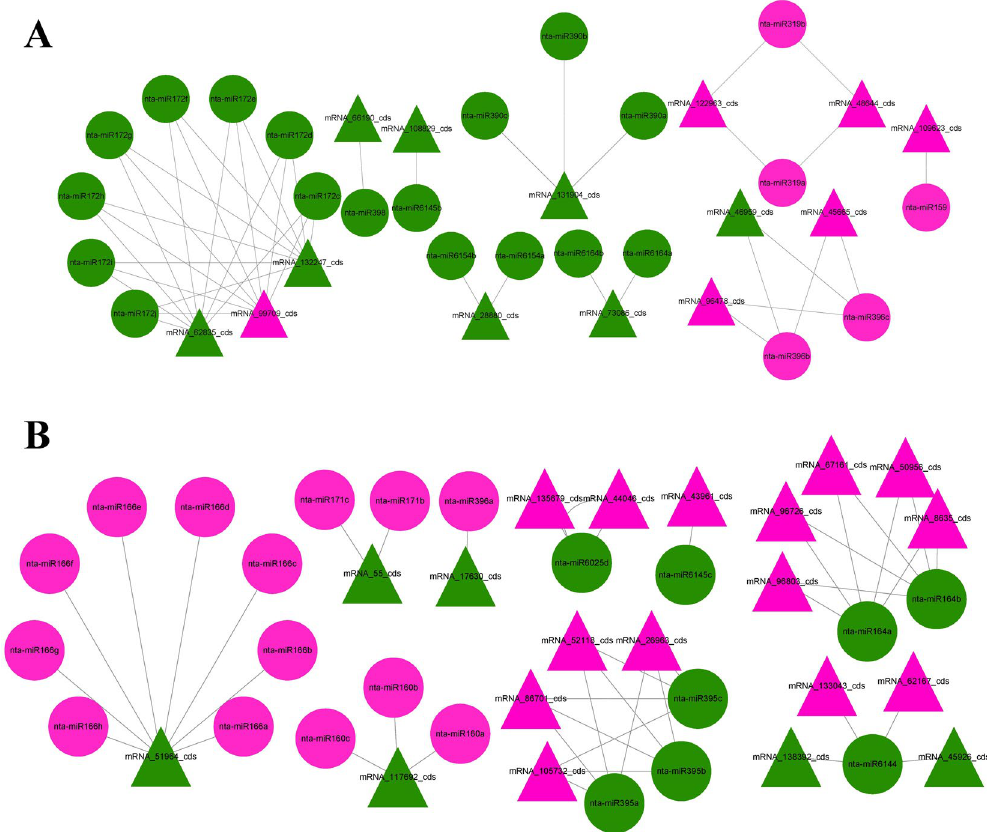
Figure 5. Combined analysis of miRNA and mRNA expression network under PVY infection.( A ) Positive regulation of miRNAs versus their target genes; ( B ) Negative regulation of miRNAs versus their target genes.The triangle represents mRNA, circle represents miRNA, green and red represent down regulate and up regulate,